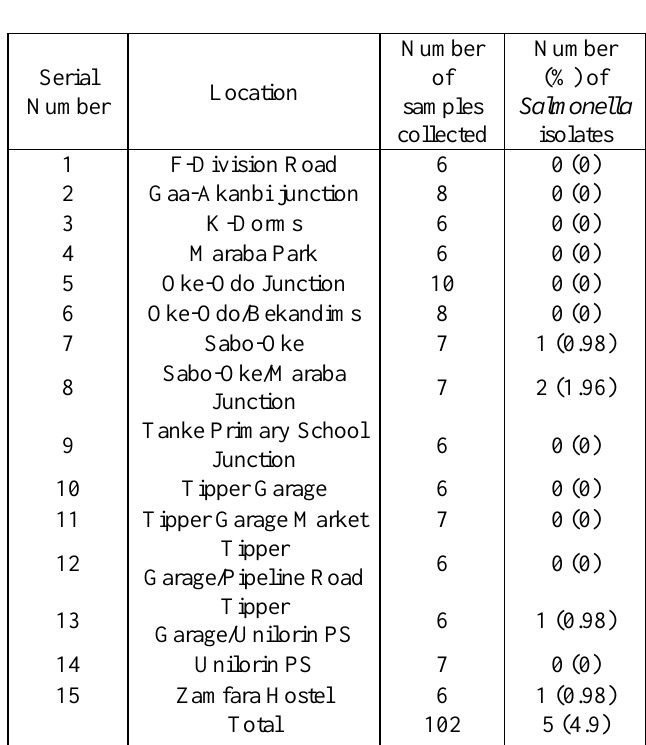
Table1: Prevalence of Salmonella spp. isolated from Suya in Ilorin, Kwara state,